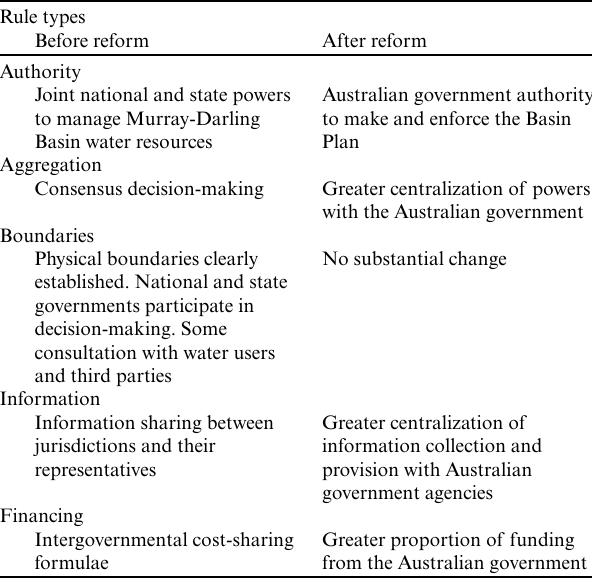
Table 2 . Major changes in Murray-Darling Basin management since